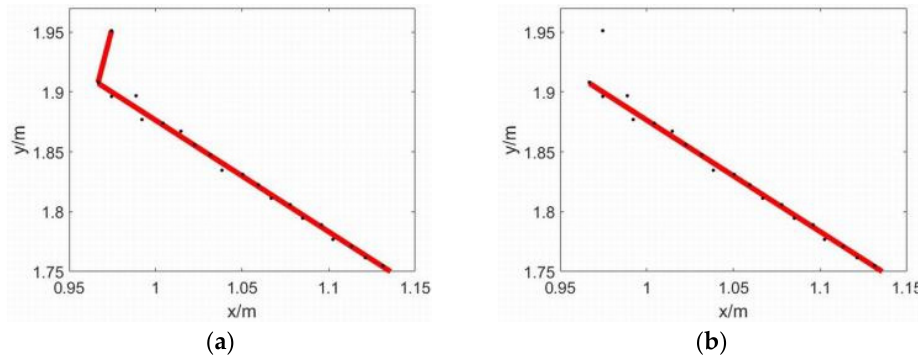
Figure 11. Area 2 line fitting results: ( a ) IEPF algorithm; ( b ) proposed algorithm.